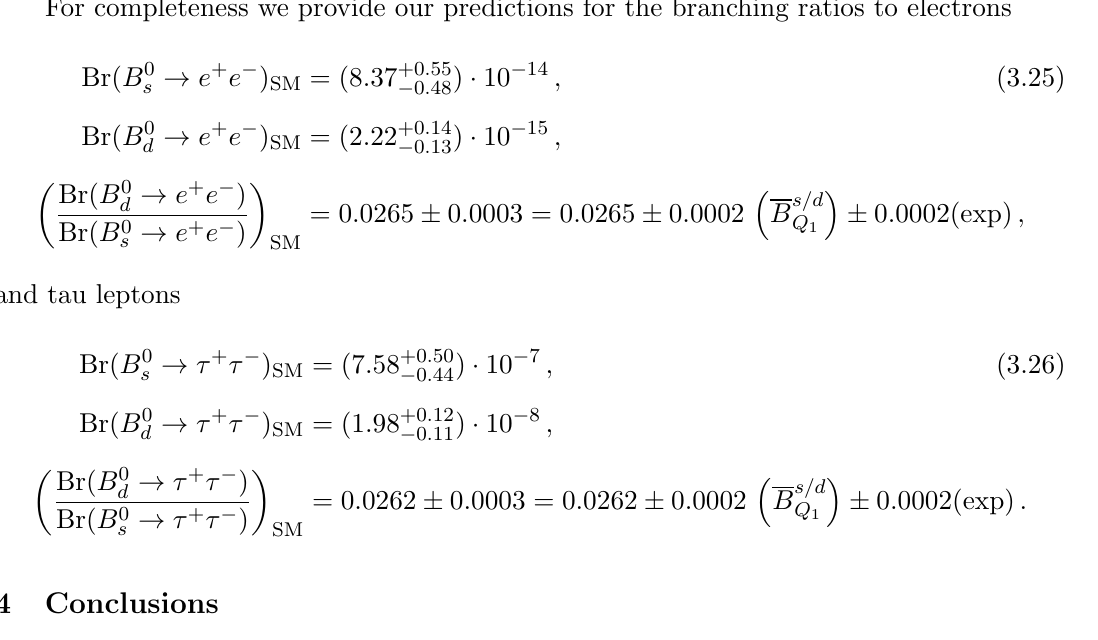
Figure 8 . We compare our prediction for the branching ratios Br( B 0 to other predictions using either the decay constants [42, 67, 69] (dashed boundaries) or the Bag parameter B q [12] (solid boundaries) as input. The experimental average for Br( B 0 Q 1 indicated by the region with the dotted